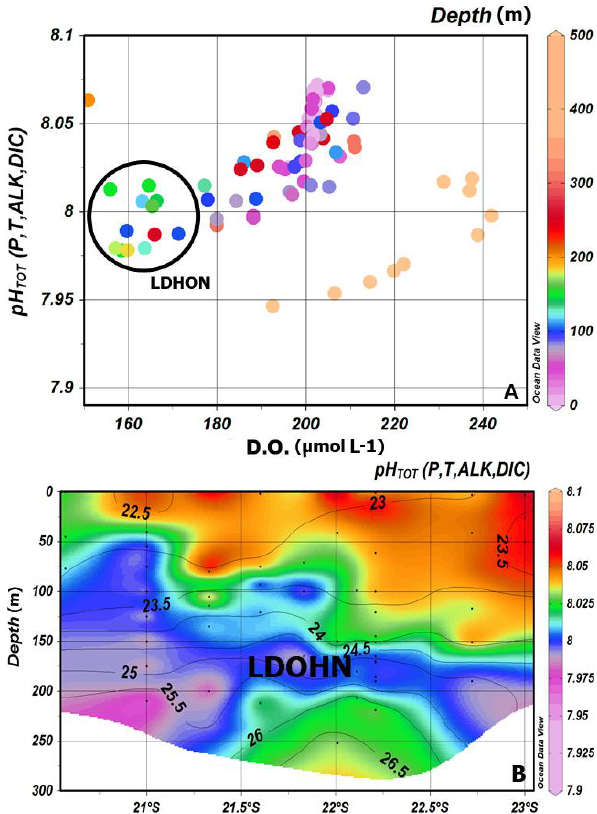
Fig. 4. (A) pH declines with lower oxygen concentrations in waters shallower than 200m, such that pH minima occur where oxygen concentrations are < 160 µmolL − 1 . Note that there are two separate relationships between oxygen and pH: one shallower than 200m and one below 400m depth. (B) Meridional pH anomaly along the ◦ C) vs. ∼ 200m contour (roughly 114–113.5 ◦ E) across the study Figure 3 497 Fig. 3. Identifying particle-rich layers: (A) temperature ( salinity plot with density contours, showing high salinity subtropi- cal water (STW) beneath tropical waters of the fresher Eastern Gy- ral Current (EGC) overlain with warmer, more saline Leeuwin Cur- rent waters at the surface (LC), probably sourced from the Indone- sian Throughflow (ITF). Transmission is indicated as dot colour. Transmission minima (maxima of particle concentrations) are seen within the forming Leeuwin Current (LC) waters ( T = 28 ◦ C, Sal = 35.3) and the Eastern Gyral Current (EGC), which is cooler and fresher ( T ∼ 24 ◦ C, Sal ∼ 34.9). LDOHN layers are visible be- tween ρ = 24 and 26kgm − 3 , showing salinity profiles scattered be- tween ρ = 24 and 26.5kgm − 3 (dashed oval). (B) Relationship be- tween transmission and salinity with dissolved oxygen (µmolL − 1 ) as dot colour. Note that the two transmission minima, at salin- ity =∼ 35 and =∼ 35.2, just offset from the LC and EGC wa- ter properties. The maximum at Sal = 35 is a major LDOHN layer whose intrusion creates the 1ρ = 0.025kgm − 3 anomaly (Fig. 1) (indicated with red arrow; see also red circle in Fig. 4), with ni- trate concentrations ∼ 2–10µmolL − 1 . Black arrow indicates more saline, warmer waters of the Leeuwin Current, in which nitrate has not been generated despite high transmission; oxygen remains high (see black circle, Fig. 4). Both peaks have relatively low NO proper- ties, but in the fresher peak has a much higher nitrate:oxygen ratio (see also Fig. 6).